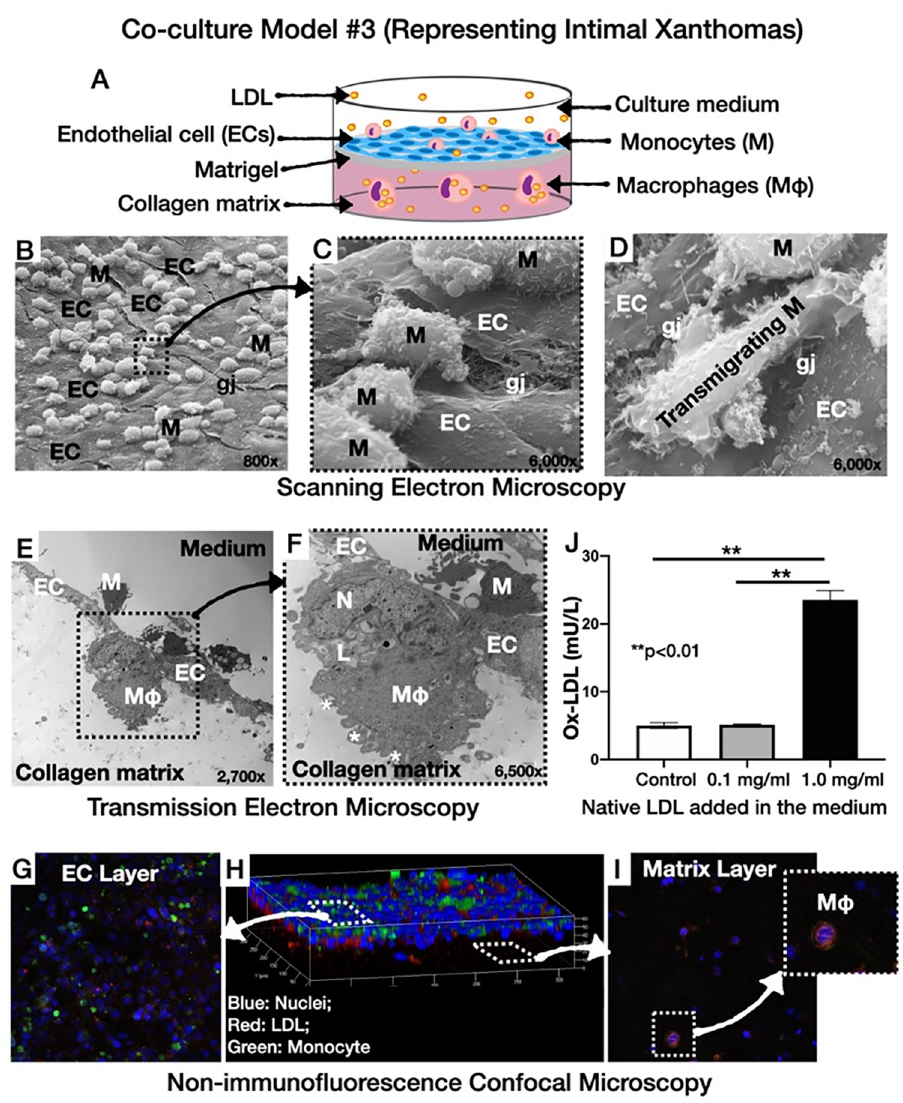
Fig 4. Co-culture model #3 representing intimal xanthomas. A : Schematic illustration: Addition of native LDL and monocytes to the monolayer of HCAECs cultured on top of Matrigel-coated collagen matrix, B-D : Scanning electron microscopic images showing the characteristic membrane changes of monocytes adhering on the ECs ( B, C ), and transmigrating through the gap junctions into the subendothelial space ( D ), E and F : Magnified transmission electron microscopic images showing the characteristic appearance of subendothelial macrophage with eccentric nucleus, villous plasma projections (white asterisks) and lipid droplets, G-I : Non-immunofluorescence confocal microscopy with pre-stained monocytes (green). Note the presence of LDL-laden macrophages in the matrix ( I ), J : Presence of oxidized LDL in the medium in a native LDL concentration-dependent manner (EC: endothelial cells; gj: gap junctions; L: low-density lipoproteins; M φ : macrophages; N: nucleus). �� p < 0.01. https://doi.org/10.1371/journal.pone.0280385.g004 with collagenase I (Sigma cat#: C-0773, 300U/mL serum-free DMEM, 2 collagen gels in 1.0 mL of the collagenase, incubated for 1 hour). Cell pellets of HCAECS and HCASMCs were suspended with 0.5 ml trypsin-EDTA and incubated for 5 minutes followed by inhibiting the trypsin activity with 0.5 ml 10% FCS-DMEM. Cells were then pelleted and re-suspended with 80 μ L serum-free-DMEM (SF-DMEM) followed by adding a 30 μ L blocking reagent and anti- CD31 microbeads to isolate the HCASMCs from HCAECs. HCASMCs were isolated by